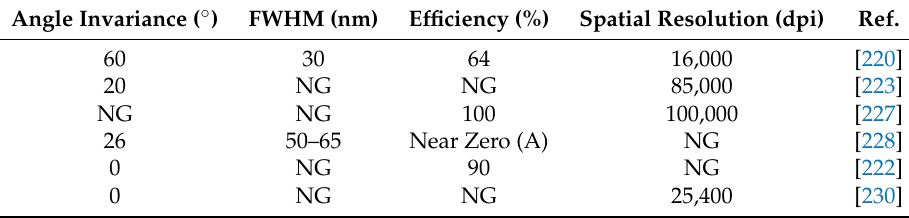
Table 4. All Dielectric-based color